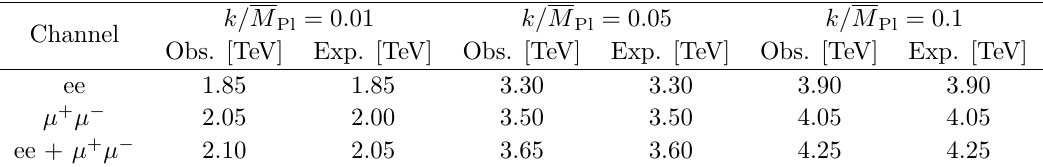
Table 5 . The observed and expected 95% CL lower limits on the masses of spin-2 resonances with widths equal to 0.01, 0.36 and 1.42 GeV corresponding to coupling parameters k=M Pl of 0.01, 0.05, and